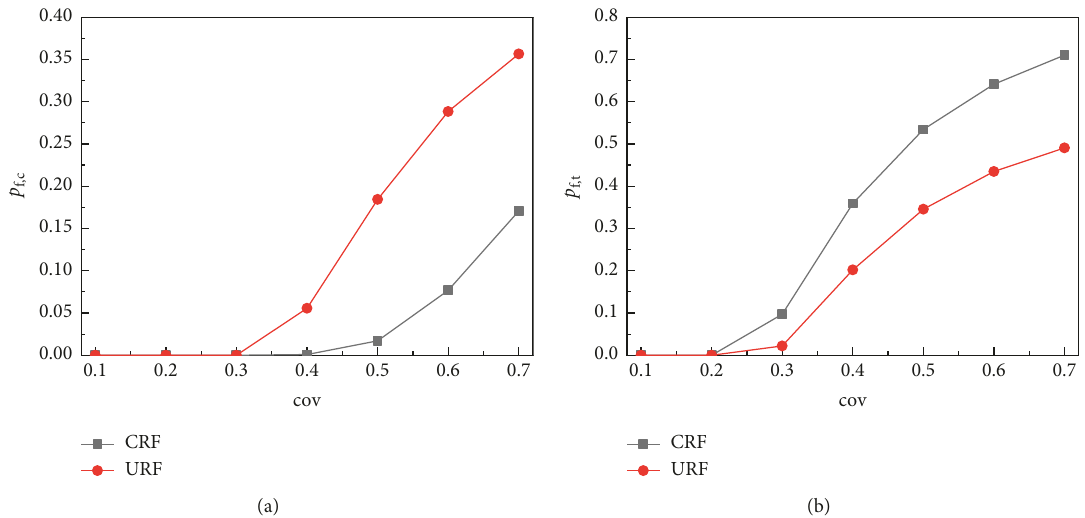
Figure 6: Effect of the coefficient of variation on the probability of failure of tunnel liner under both unconditional and conditional random fields: (a) compression failure and (b) tension failure.